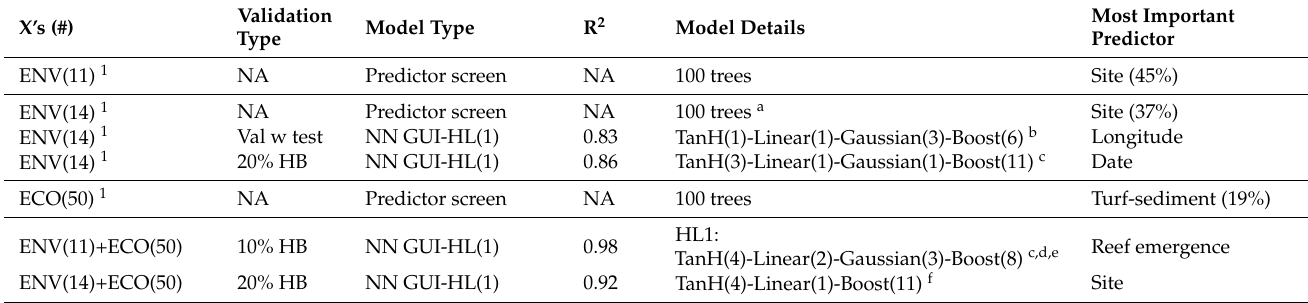
Table 3. Environmental and ecological (i.e., benthic) predictors of the coral health index (CHI; sinH- arcsineH [SHASH]-transformed). In all models, CHI was the Y, and first, second, and third-order factorial combinations of the 11–14 environmental parameters and/or 50 ecological predictors were considered. “ENV(14)” = those of Table 2. “ENV(11)” = the former 14 minus site, date, and time of day. The neural network (NN) GUI, models ( n > 1500) were run with either one (“HL(1)”) or two (“HL(2)”) hidden layers (HL); with the former, up to 20 boosts were allowed (learning rate: 0.05–0.3). The number of activation nodes ranged from 0 to 4, the weight decay penalty was used, and up to 100 tours were considered. When test samples were used in addition to validation (Val) samples (Val w/test), the test R 2 is shown in the “R 2 ” column; all other values represent validation R 2 (from 10–20% holdback [HB] or validation column [Val col]-based validation). Models with R 2 < 0.8 are instead shown in Table S2. For the predictor screening analysis, the percent variation explained by the most important predictor has been shown in parentheses. Superscripts following text in the “X’s (#)” column correspond to factorial degree (i.e., first-order). NA = not